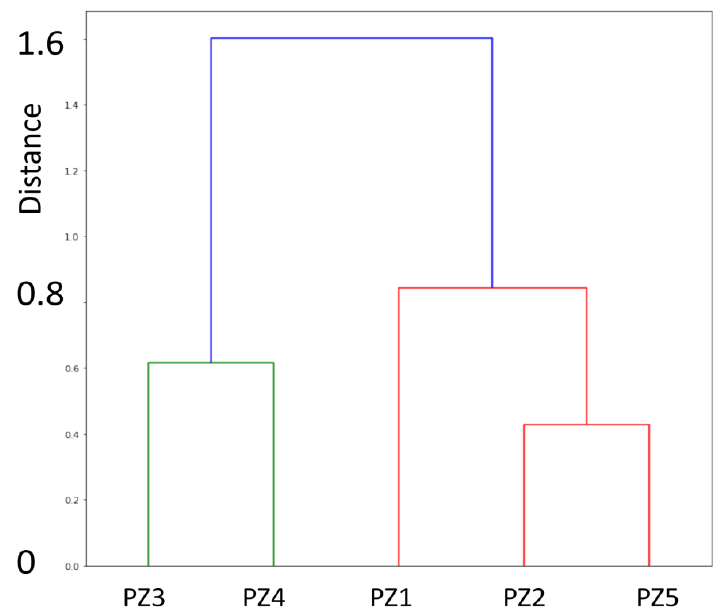
Figure 8. Hierarchical Classification method-results with the pressure data.